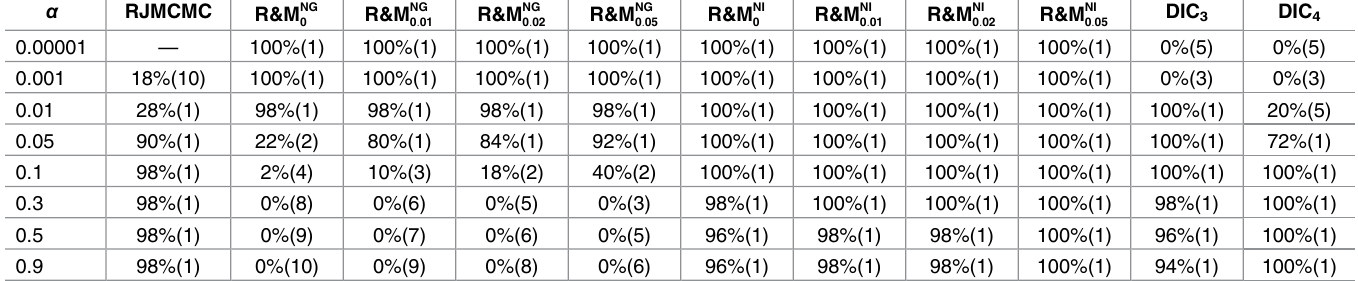
Table 1. The results of Scenario A1. Percentage of data sets in which the true number of clusters was found, with the mode of the estimated numberof clas- ses in